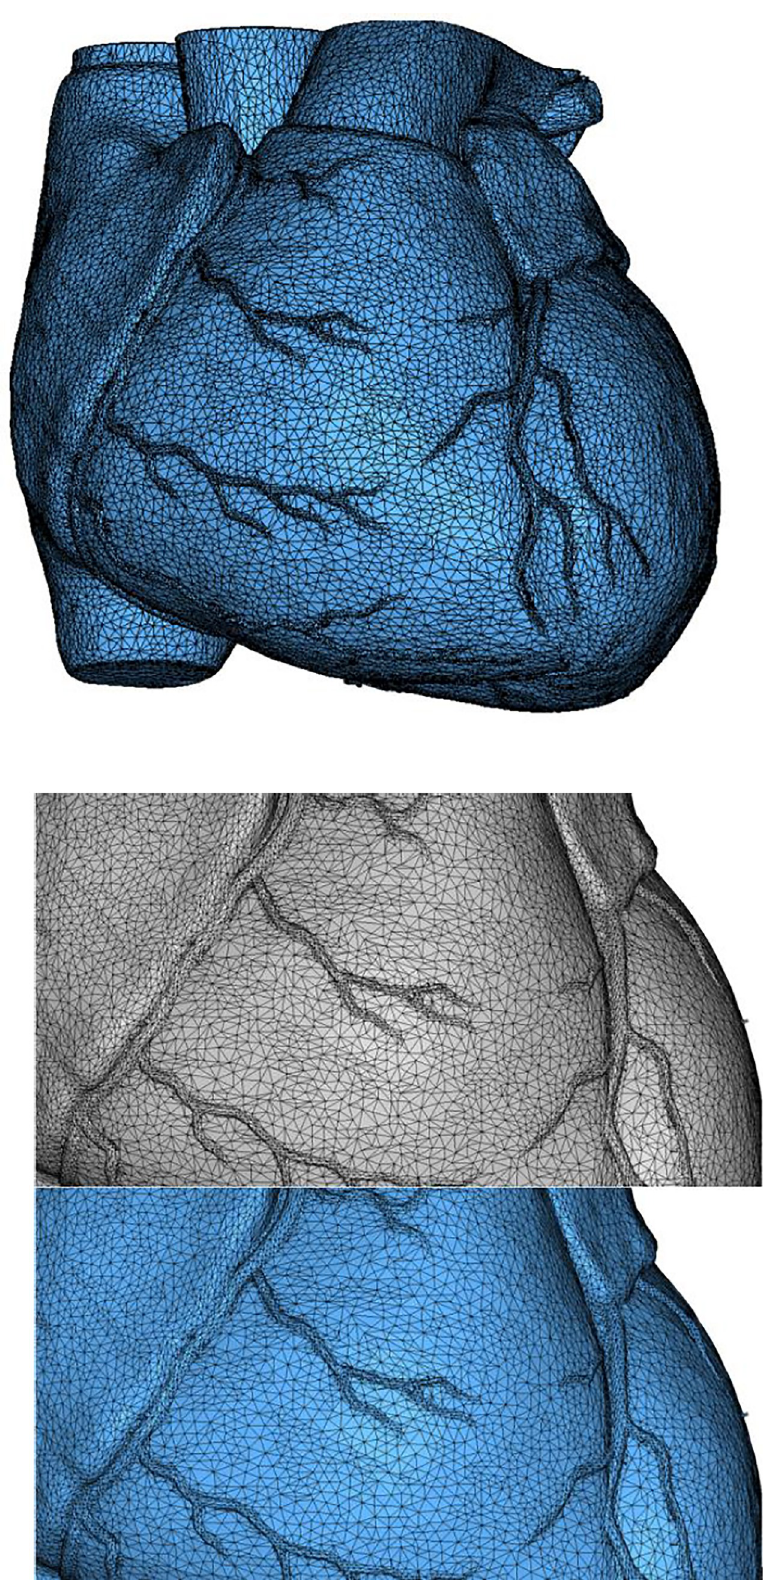
Fig 17. a) Initial mesh of Example 6; b) local comparison of mesh before(up) and after(down) EAS smoothing.